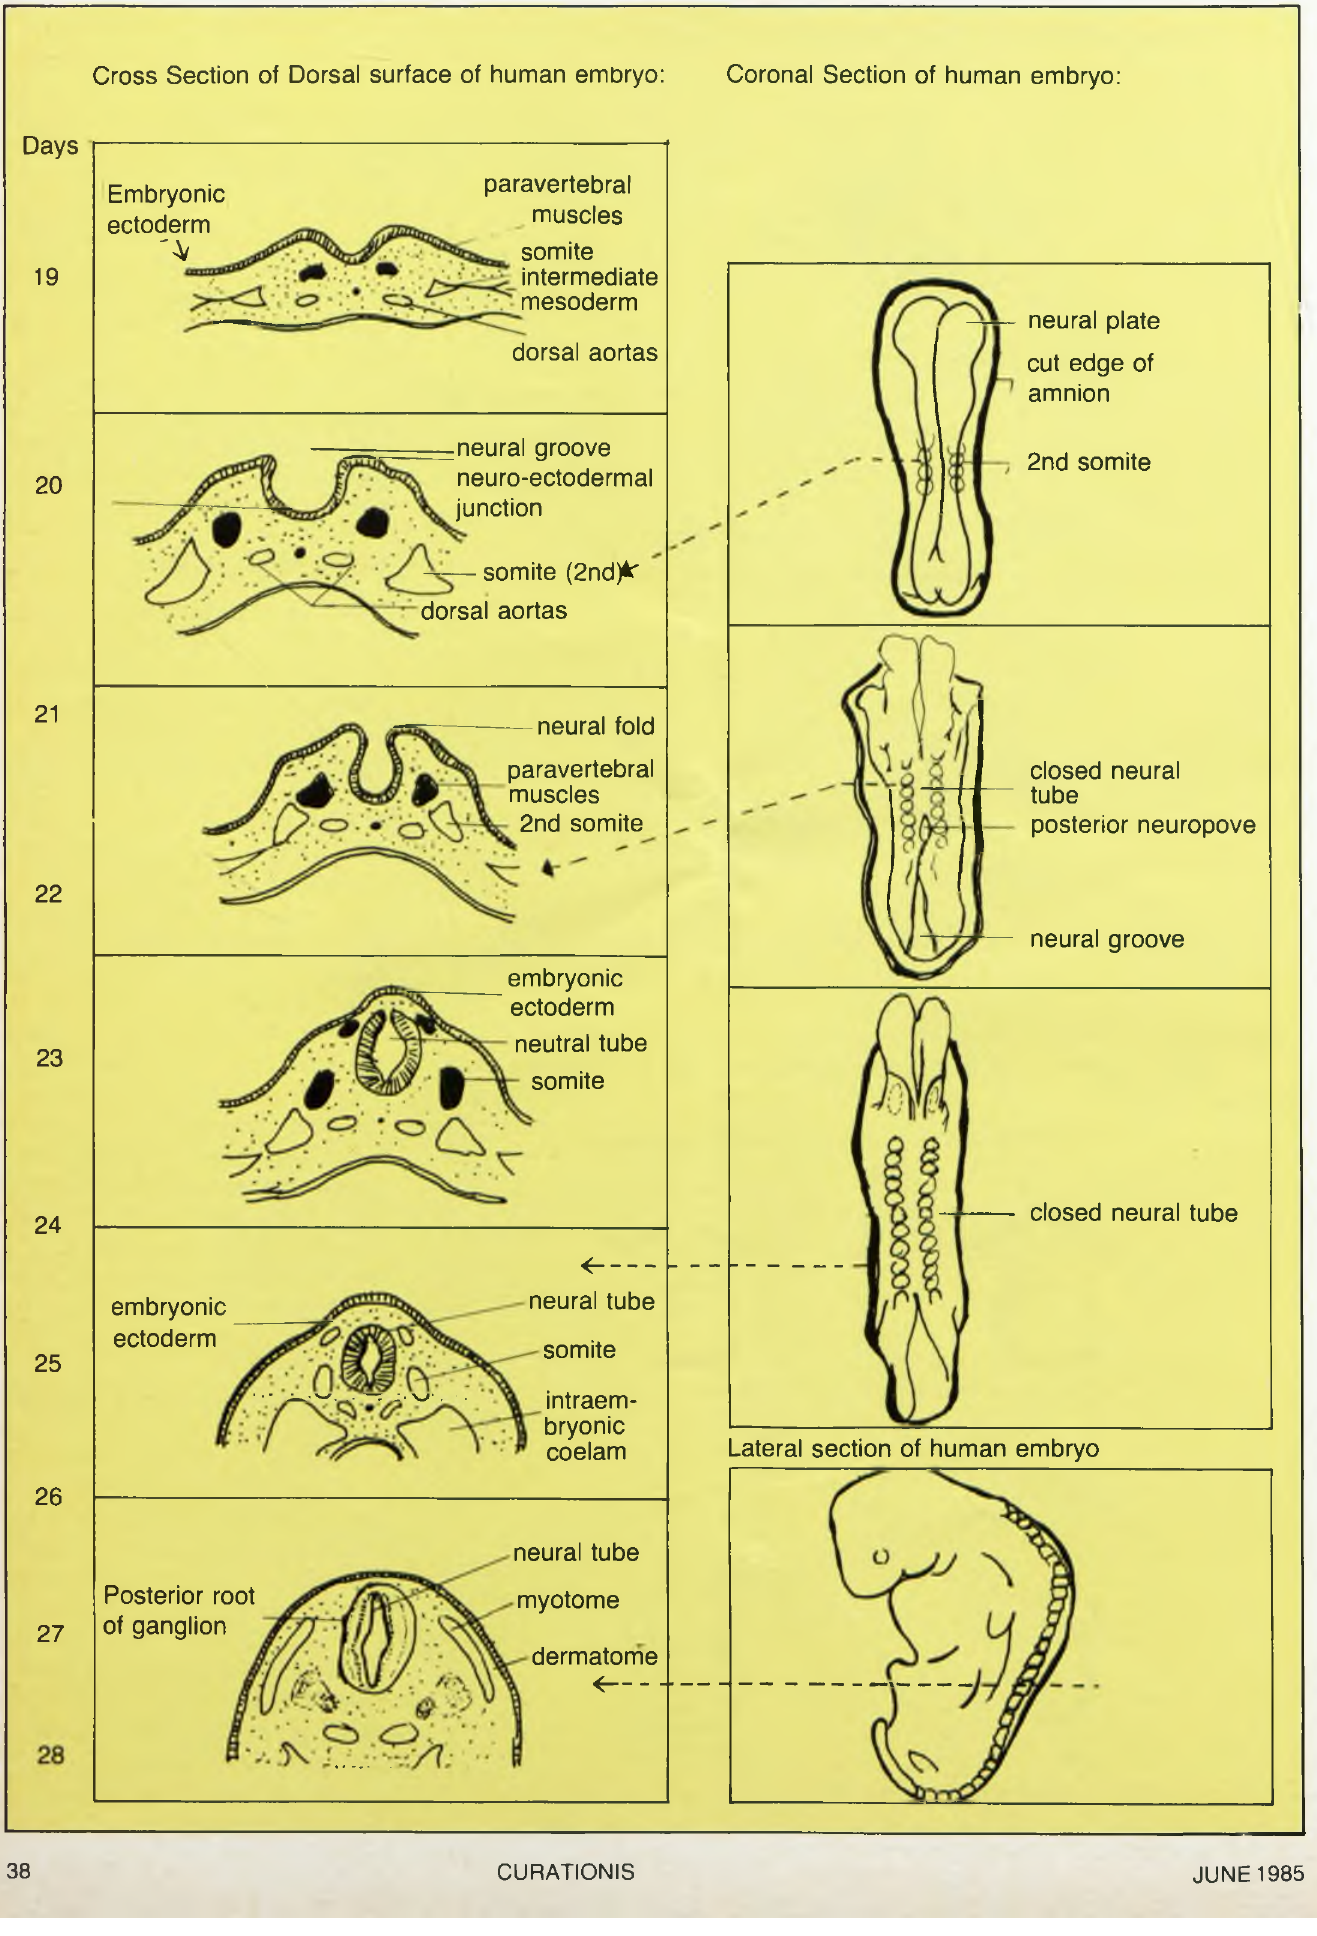
Cross Section of Dorsal surface of human embryo: Coronal Section of human